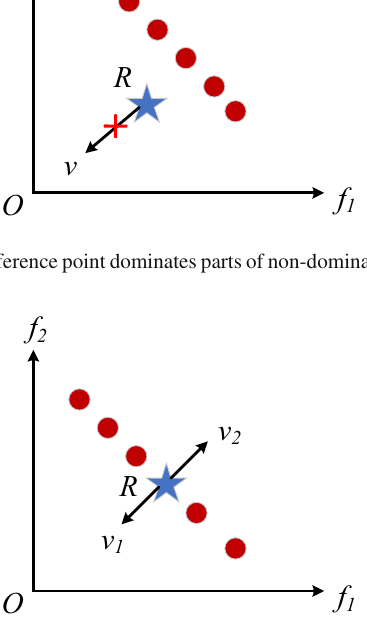
In Fig. 4, the reference point R (blue star) and the non- dominated solutions (red points) are non-dominated by each others. In this case, any directions of movements are possible,